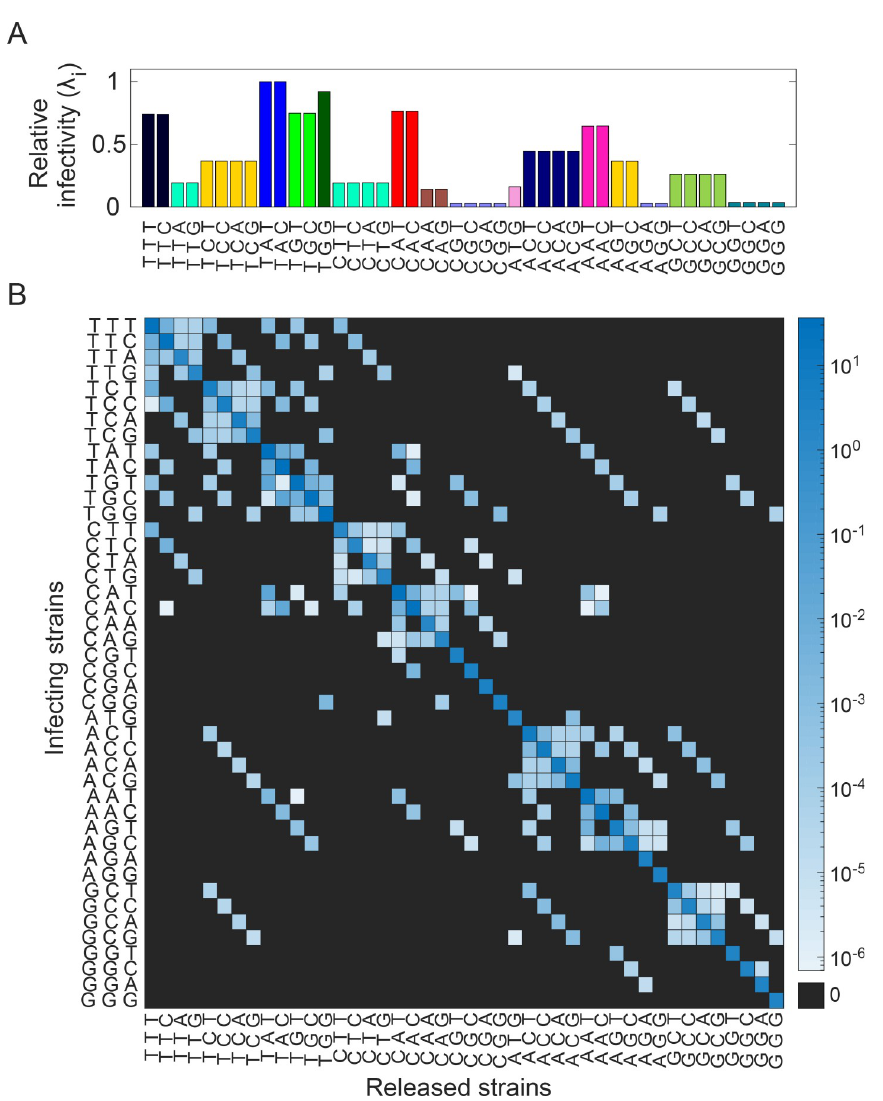
Fig 6. The relative infectivity and specific release rate of mutants at position 93 of the NS5A protein. (A) The probability of infection of virions carrying different codons, color coded by the amino acids they encode. (B) The specific release rate matrix summarized as a heat map from the data in S5